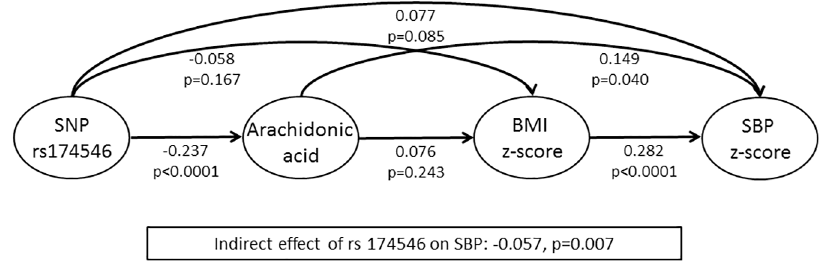
Fig 3. Path model for the associations between the SNP rs174546and SBP z-score via ARA and BMI z- score: Standardized direct effectsand p-values.